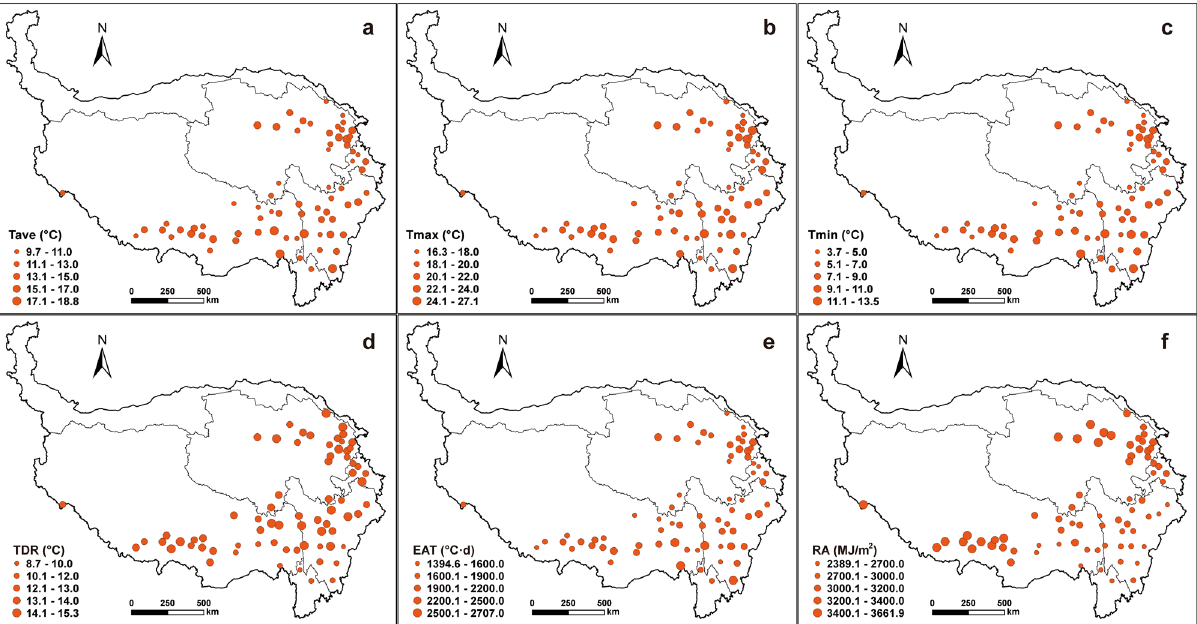
Figure 4. Long-term annual averages of Tave ( a ), Tmax ( b ), Tmin ( c ), TDR ( d ), EAT ( e ) and RA ( f ) in the growing season at 72 stations in the Qinghai-Tibet Plateau from 1978 to 2017. The size of circle is proportional to the values. Maps were generated using ArcMap 10.7 software ( © ESRI, https:// deskt op. arcgis.